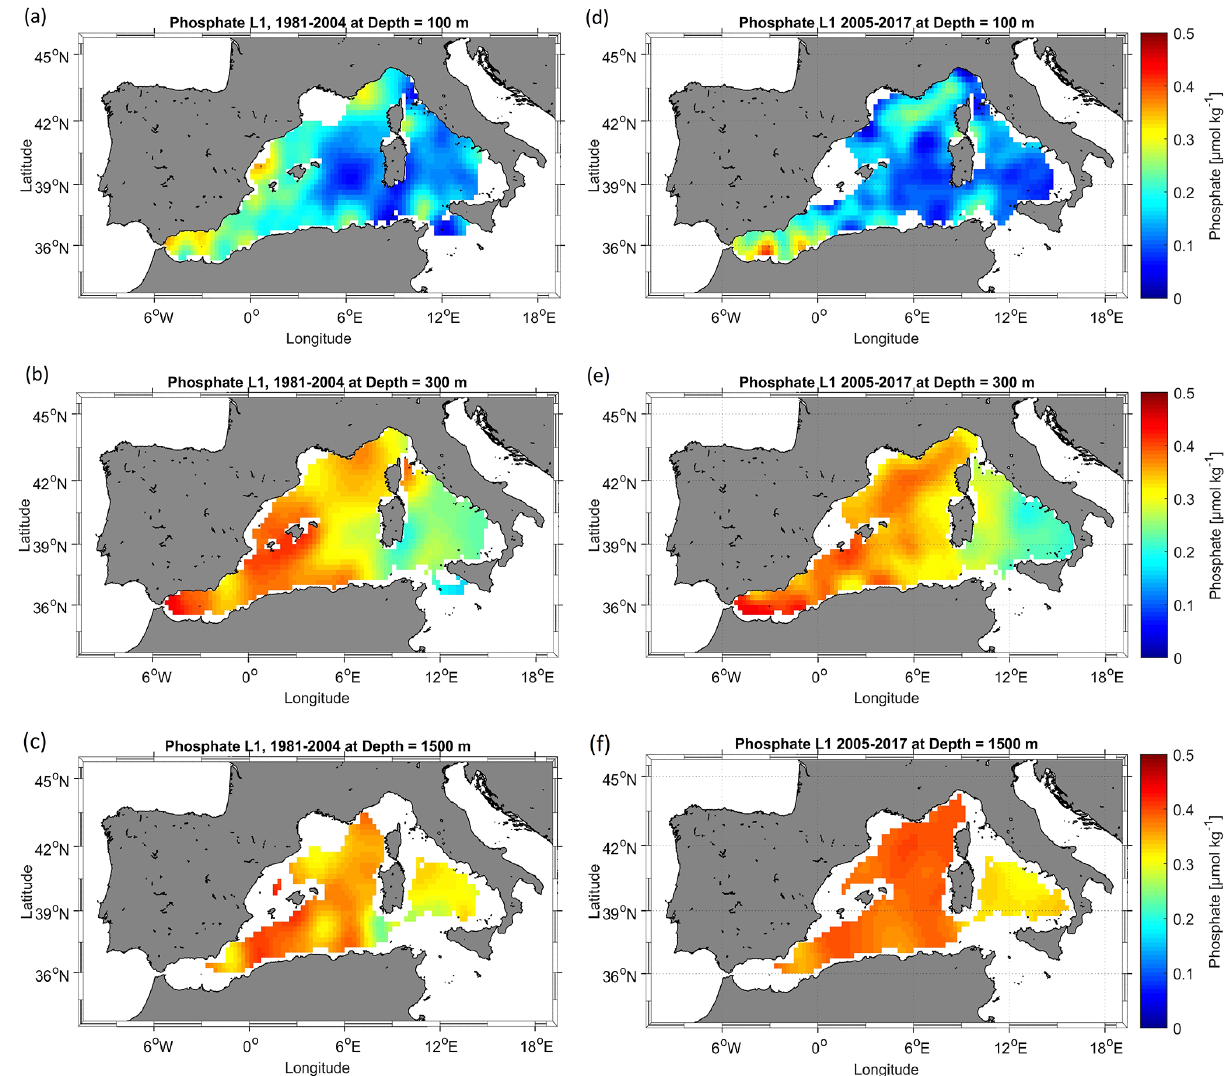
Figure 20. The same as Fig. 19 but for